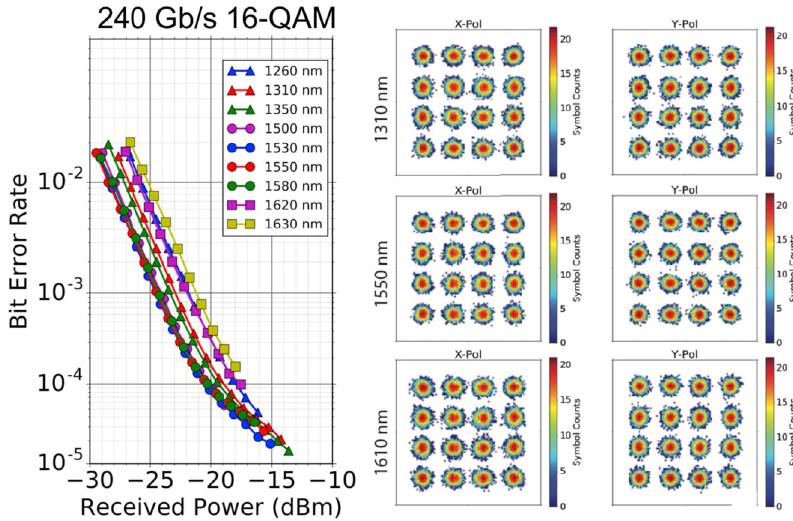
Figure 12: Performance of a commercial silicon photonic coherent transceiver over 370 nm at 240-Gb 16-QAM